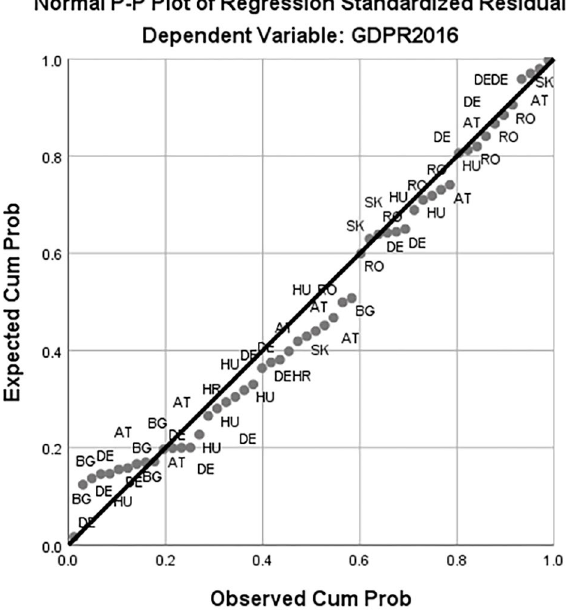
Figure 5. P-P Plot for sustainable development of EUSDR in